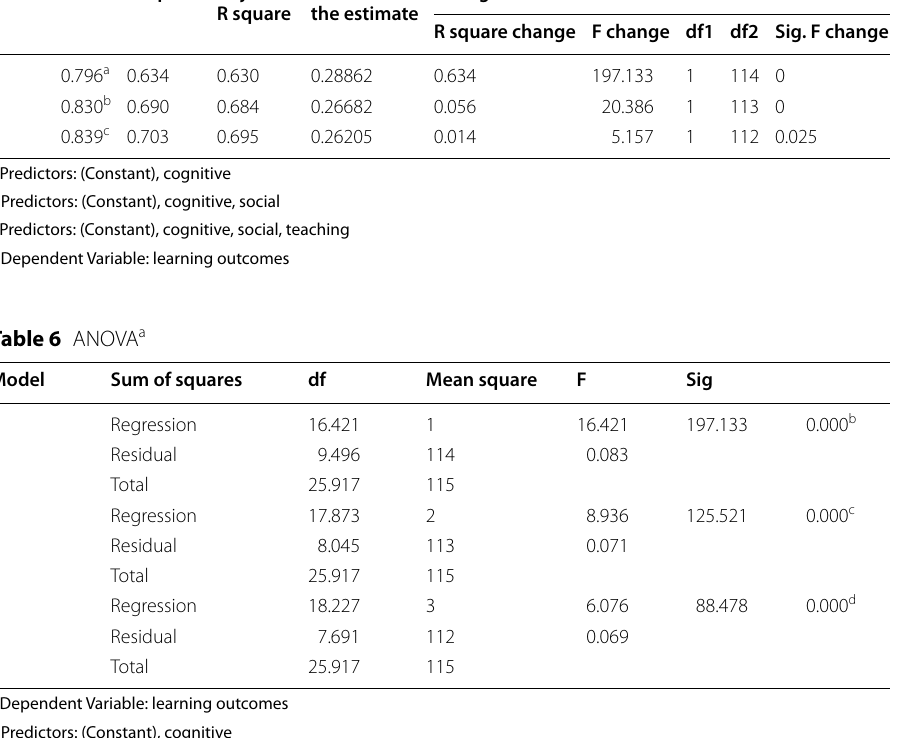
Table 5 Model Summary d